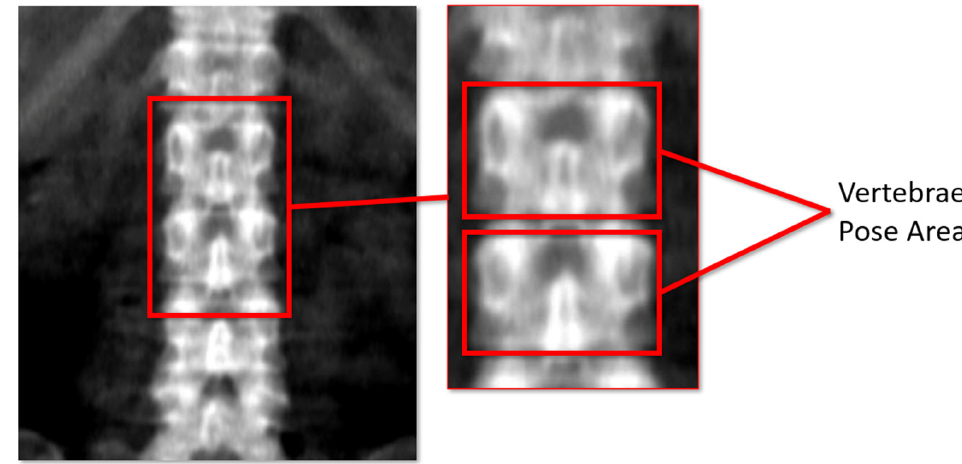
Figure 1. Lumbar vertebrae pose in low contrast condition .